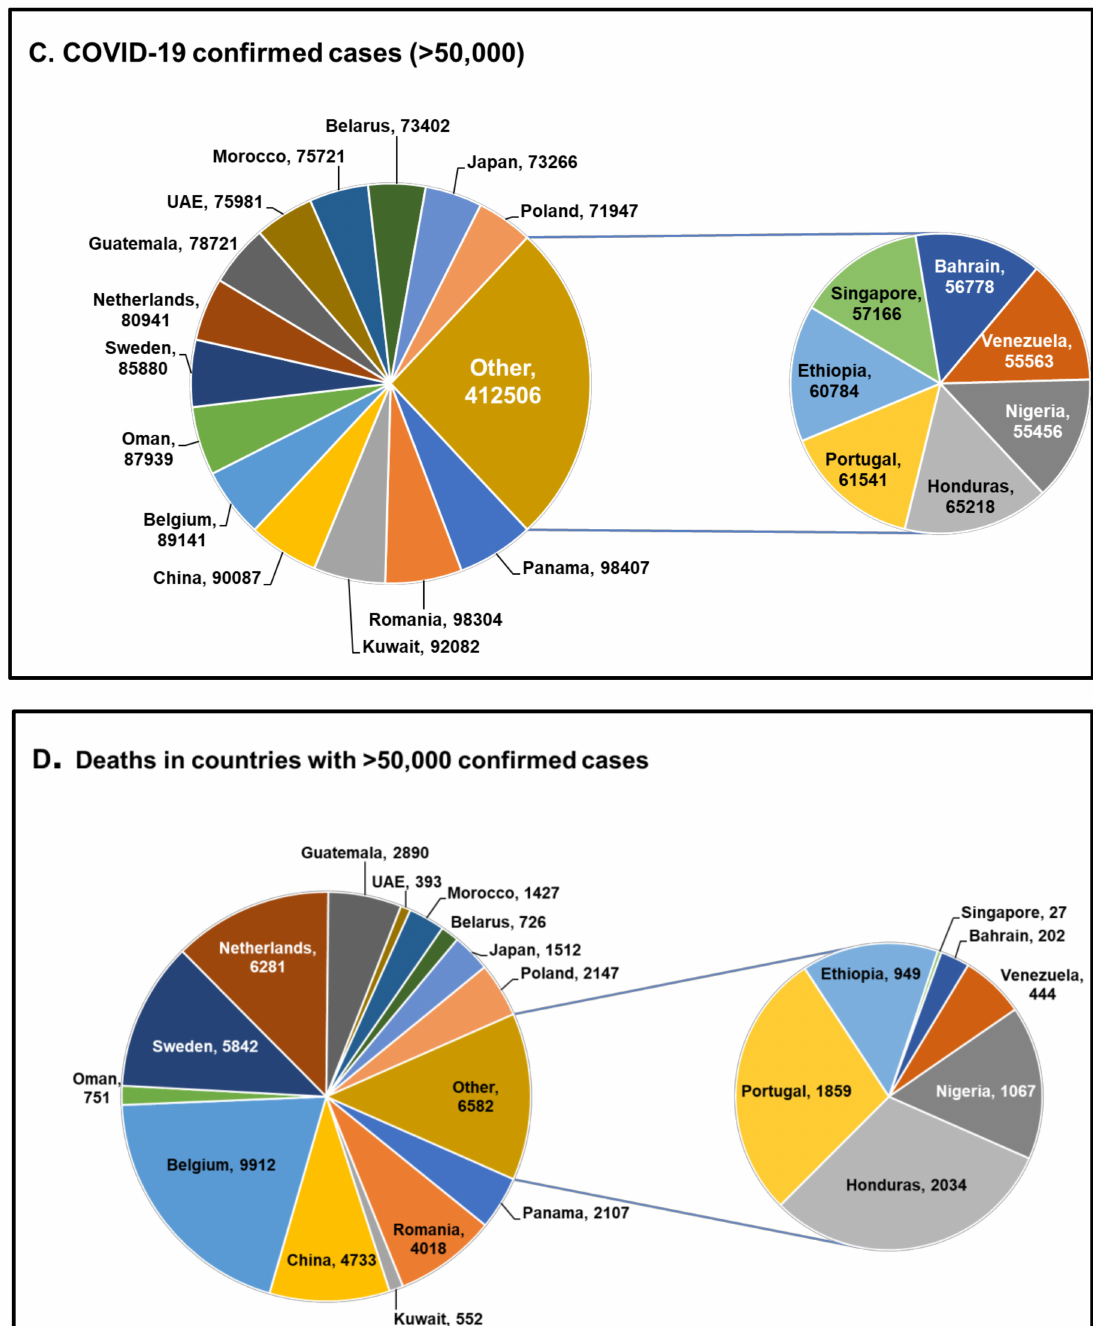
Figure 1. Demographics of COVID-19 cases and deaths. ( A ) COVID-19 confirmed cases by countries ( > 100,000 cases) and ( B ) global deaths. ( C ) COVID-19 confirmed cases by countries ( > 50,000 cases and < 100,000) and ( D ) global deaths. Based on data obtained from COVID-19 dashboard by Center for Systems Science and Engineering (CSSE) at Johns Hopkins University